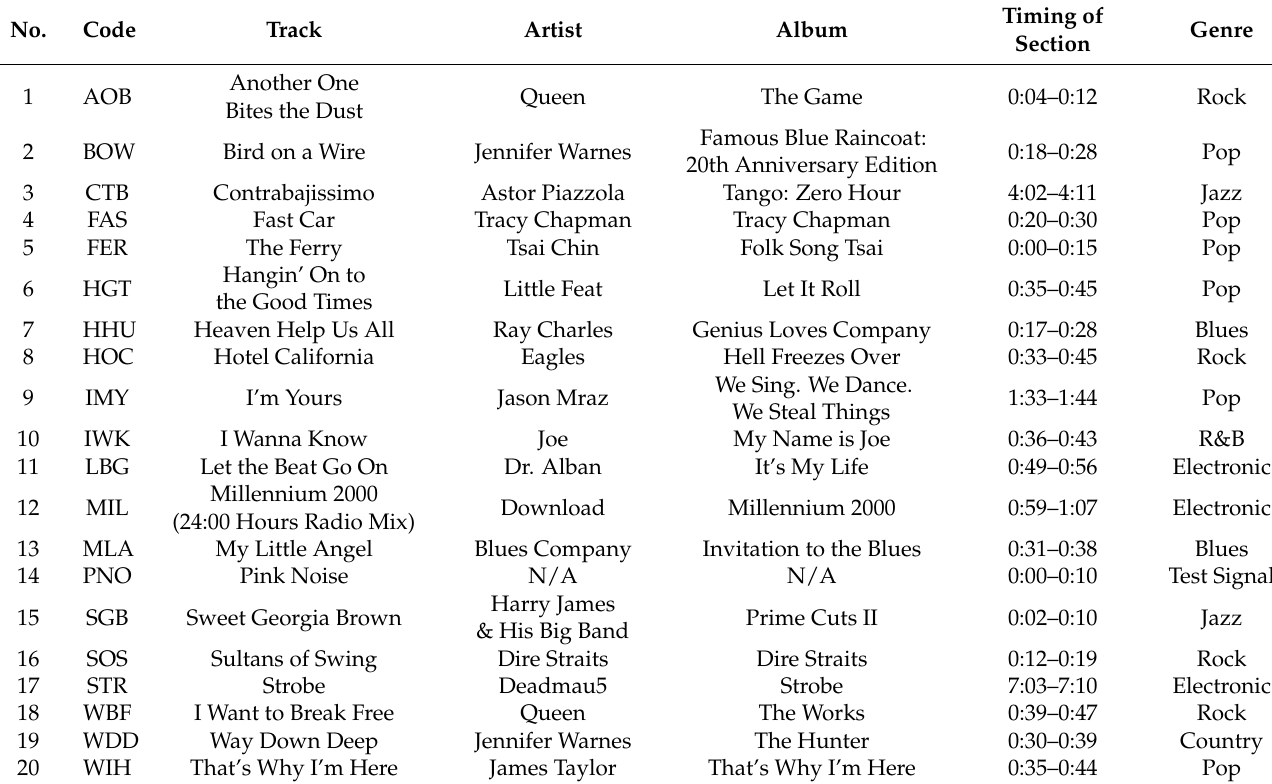
Table 1. Specifications of the program